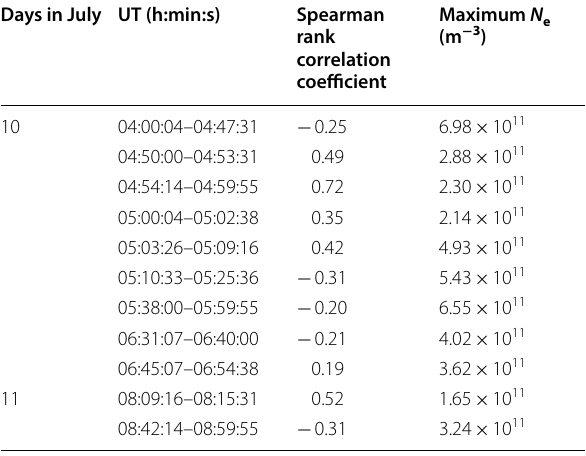
Table 4 Comparison of maximum N in 1 h, having positive and negative Spearman rank correlation coefficient